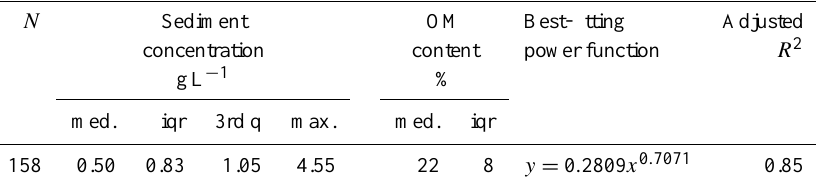
Table 4. Sediment concentrations and corresponding organic matter (OM) contents of the streamflow samples at the catchment outlet, and best-fitting power function between sediment concentration ( x ; in gL − 1 ) with normalized light loss ( y ). Med.: median; iqr: inter-quartile range; 3rd q: third quartile; max.: maximum. N Sediment OM Best-fitting Adjusted concentration content power function R 2 gL − 1 % med. iqr 3rd q max.